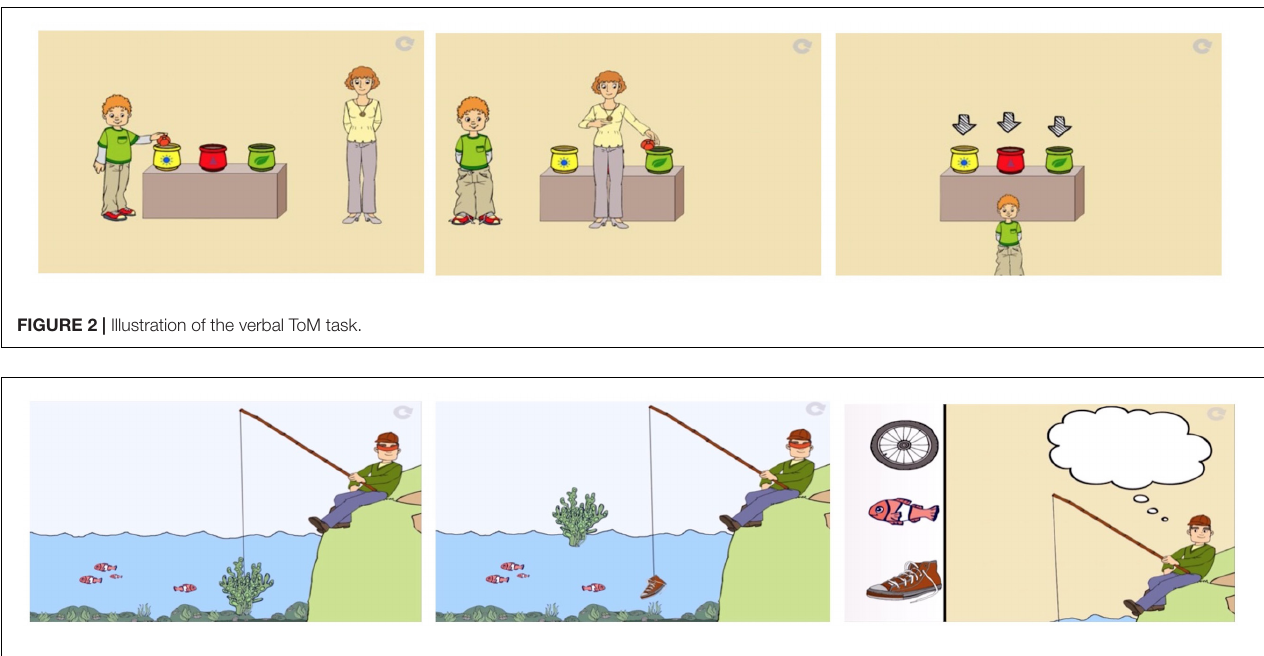
FIGURE 3 | Illustration of the low-verbal ToM